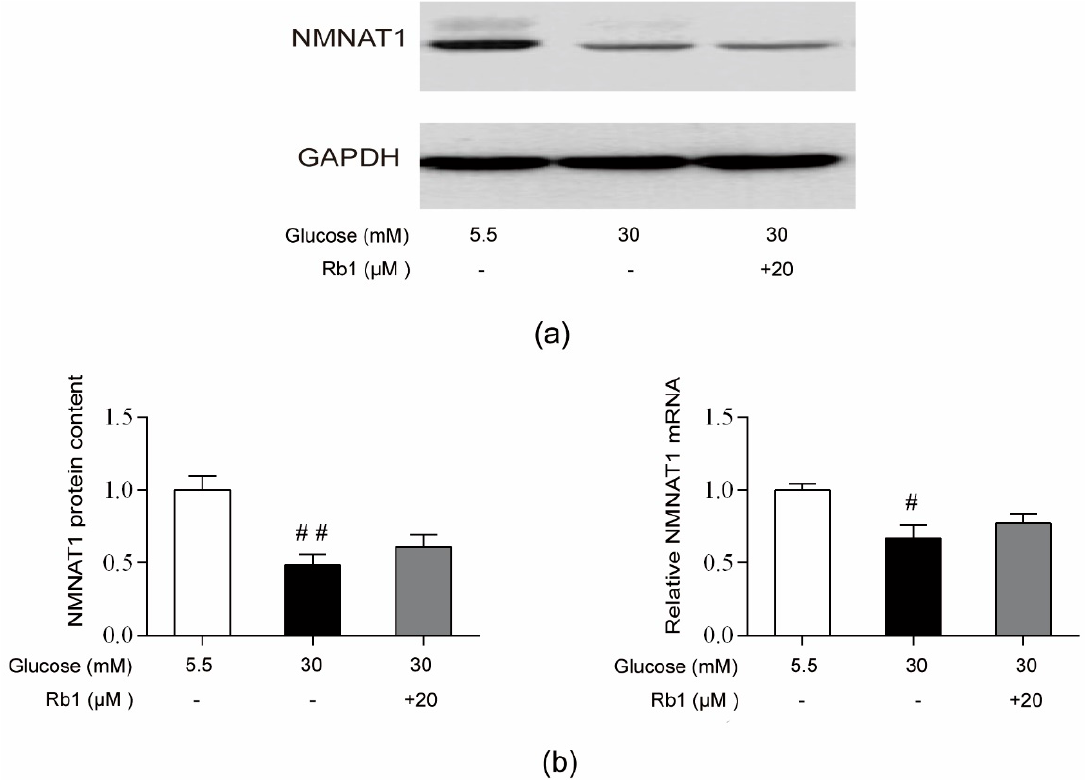
Figure 7. Rb1 treatment showed no effect on NMNAT1 expression in rat RCECs exposed to high glucose. ( a ) Western blot analysis was used to determine NMNAT1 protein expression. ( b ) The relative densities of NMNAT1 protein expression were determined by image analysis with Image-Pro Plus 6.0 software. ( c ) RT-qPCR was used to determine NMNAT1 mRNA expression. Data are expressed as the means ± SD. ## p < 0.01 versus 5.5 mM glucose; ** p < 0.01 versus 30 mM glucose.